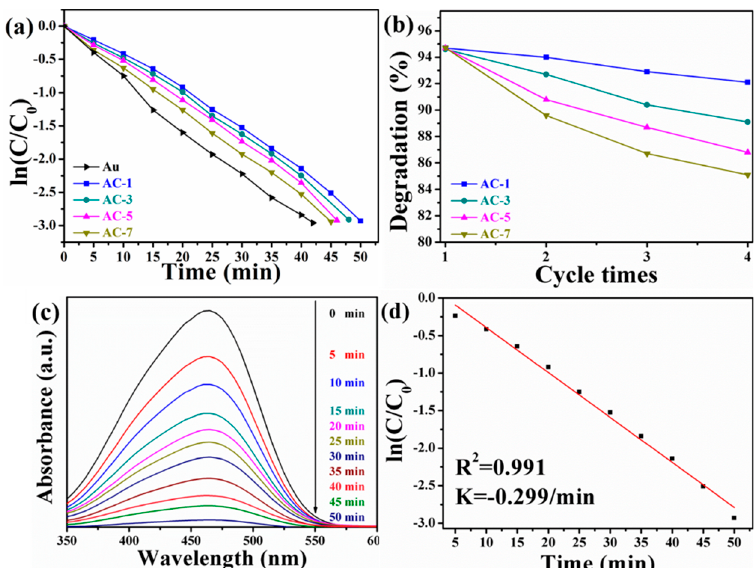
Figure 6. Time-dependent efficiency ( a ) of degrading MO solution catalyzed by Au nanocrystals, AC-1 NCs, AC-3 NCs, AC-5 NCs, and AC-7 NCs and recycle experiments ( b ) of degrading MO solution by AC-1 NCs, AC-3 NCs, AC-5 NCs, and AC-7 NCs. Time-dependent UV–Vis absorption spectra ( c ) and corresponding pseudo-first-order kinetic reaction plots ( d ) for reduction of MO catalyzed by AC-1 NCs.